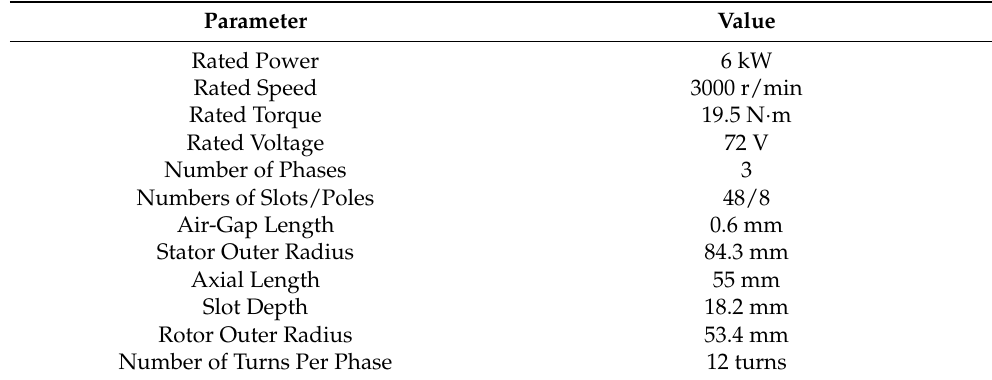
Figure 7. Magnetic flux density cloud diagram and magnetic flux distribution of the motor. Table 1. Main parameters of the designed motor.